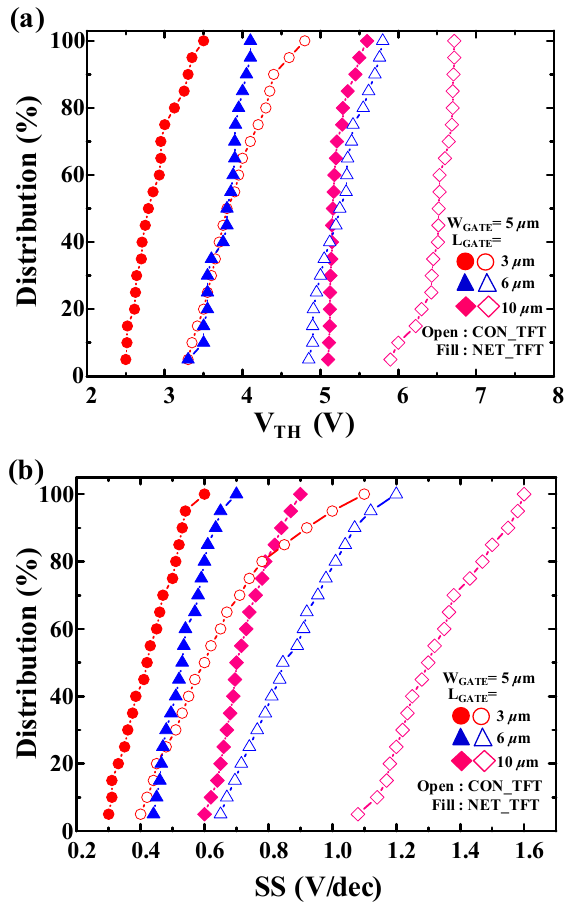
Figure 7. Cumulative distribution of ( a ) V TH and ( b ) SS for NET_TFT and CON_TFT (20 devices). Table 1. Average and standard deviation of V TH and SS for NET_TFTs and CON_TFTs with differ- ent L GATE .